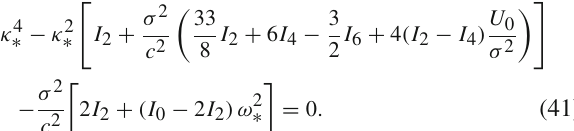
Fig. 1 Dimensionlessfrequencyasfunctionofthedimensionlesswave number vector modulus for the post-Newtonian ( σ/ c = 0 . 07) and New- tonian ( σ/ c = 0)